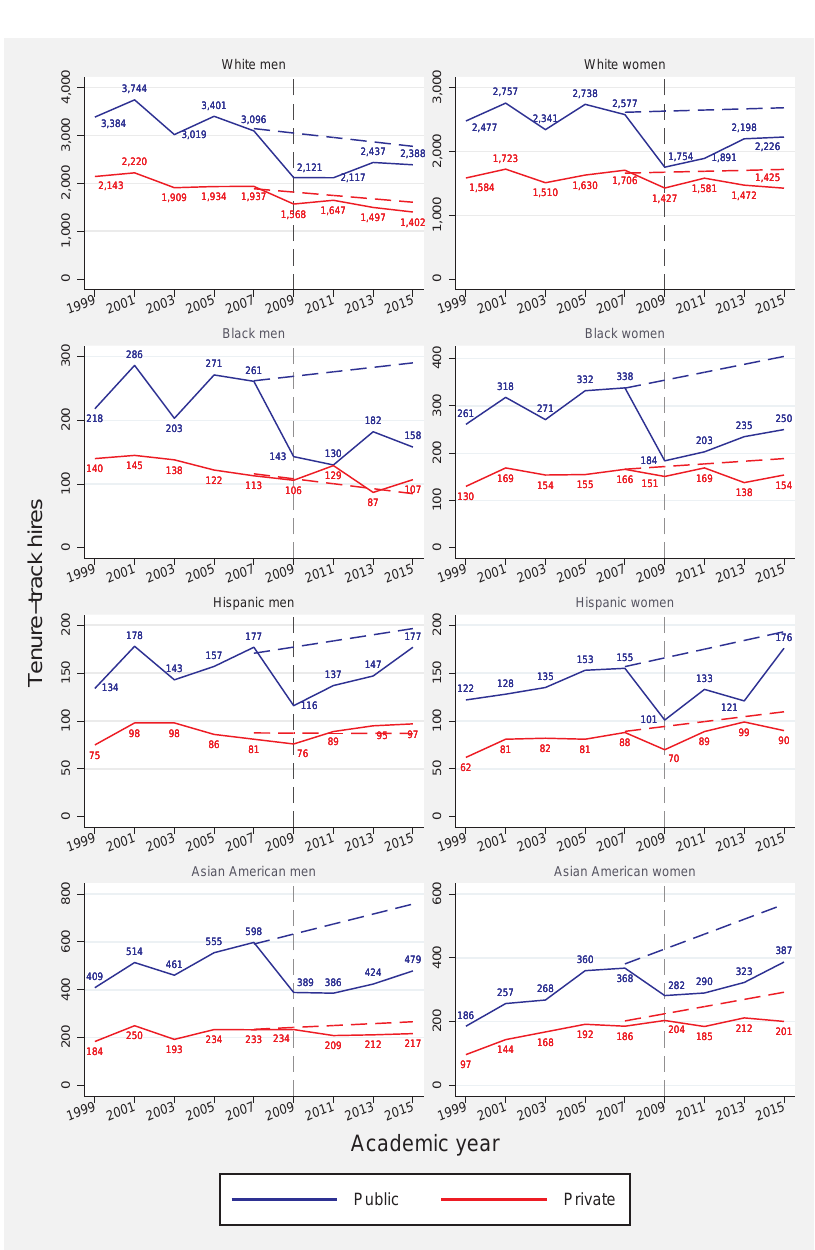
Figure 3: Tenure-track hires by demographic group in public and private institutions. Dotted lines extend pre-recession (1999 to 2015) trends based on bivariate regression estimates.